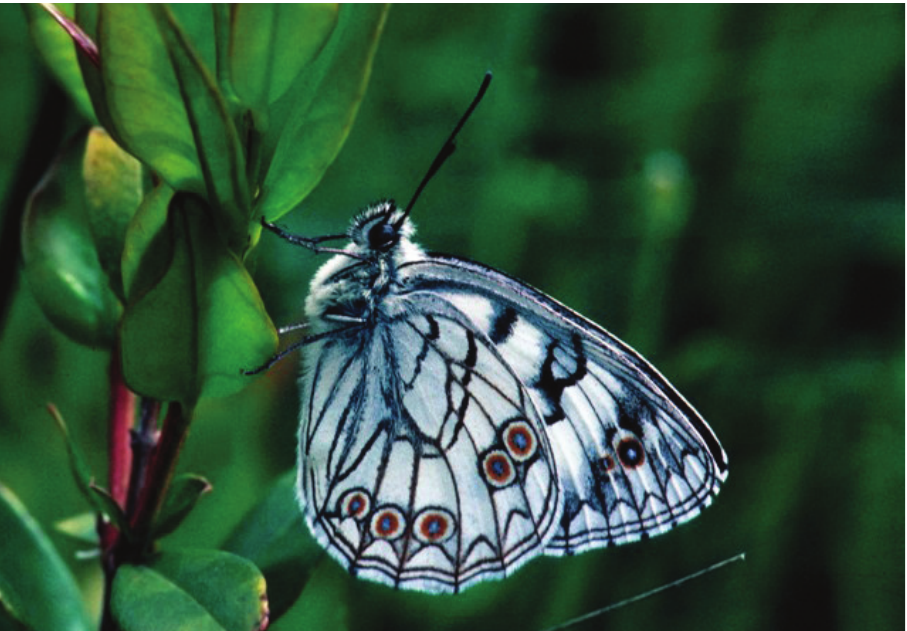
The Italian Marbled White occurs locally in small populations on rocky, calcareous places on patches of dry, grassy vegetation among loose thickets of Prickly Juniper ( Juniperus oxycedrus ), Rosa sempervirens , the Bramble ( Rubus ulmifolius ) and Thymus capitatus , with a few scattered trees. The caterpillars feed on grasses such as Feather Grass ( Stipa pinnata ) and the false-brome ( Brachypodium retusum ). The Italian Mar- bled White has one generation a year which only flies for three weeks. Detailed habitat descriptions are not available. This is a European endemic